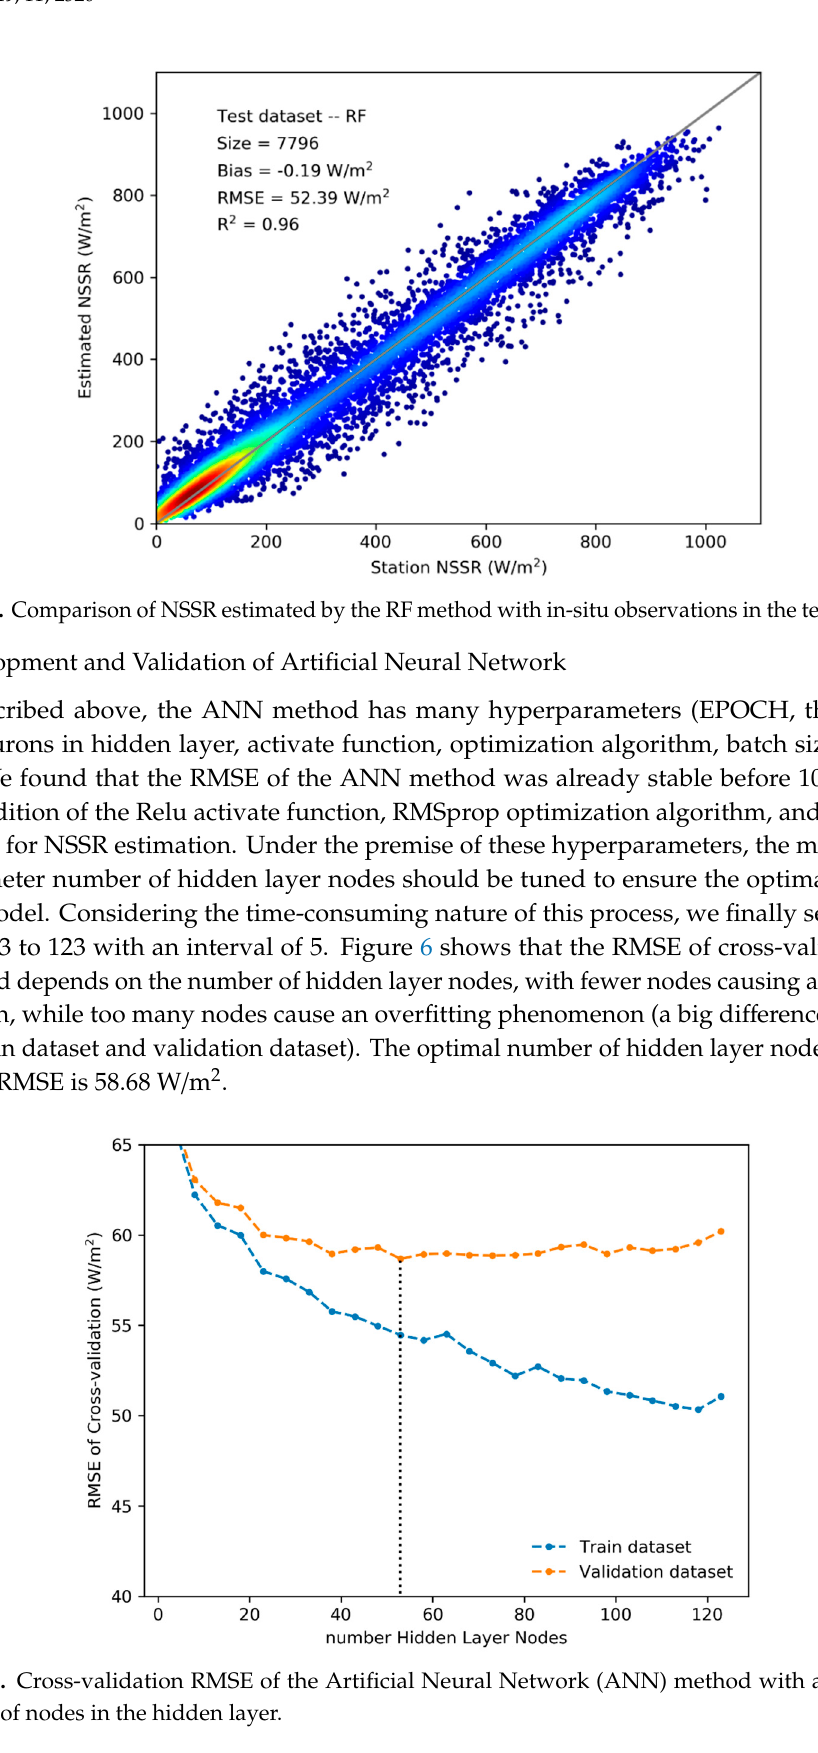
Figure 5 shows a comparison of estimated instantaneous NSSR and in situ reference NSSR in test